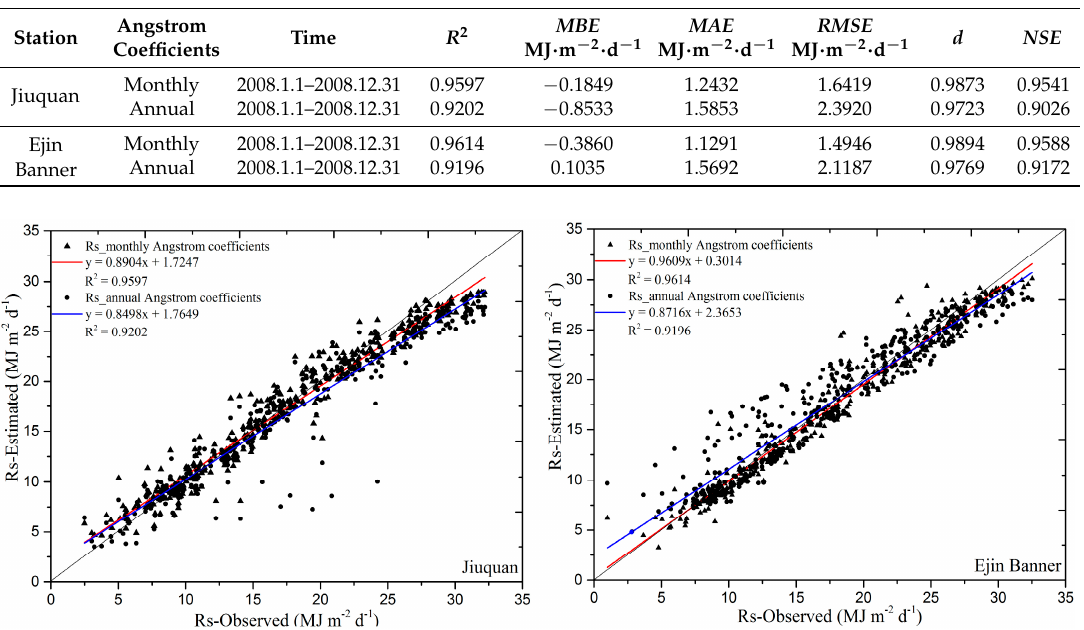
Table 5. Statistics for the performance of the global daily solar radiation estimated by the proposed method at Jiuquan and Ejin Banner stations in 2008 (366 days).